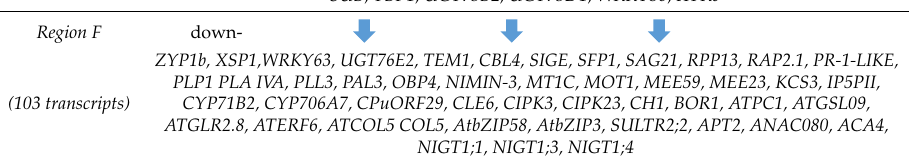
Table 3. Selection of the most annotated transcripts present in the Venn diagram regions G to N of Figure 5. All significantly modulated transcripts were filtered using Log 2 FC ≥ |1.00| as threshold in at least one of the comparisons. ( N = 3, q -value < 0.05). Red arrows, upregulated transcripts; blue arrows, downregulated transcripts; transcripts directly involved in N acquisition are shown in bold. For each region, the complete list and annotation of the genes is reported in Table S4.